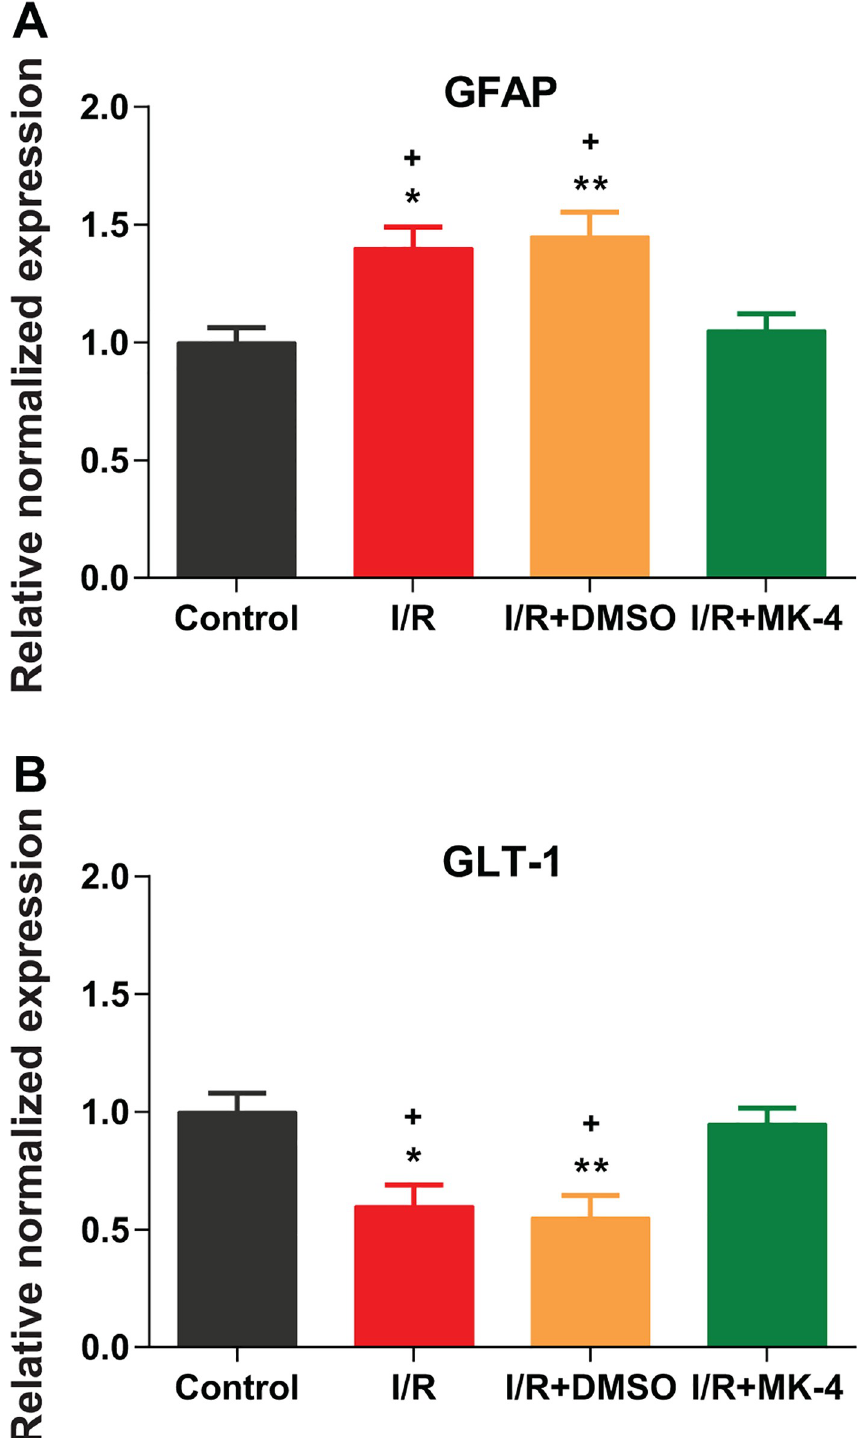
Fig 8. Reduced astrogliosis and EAAT2 (glutamate transporter 1, GLT-1) induction following MK-4 administration in I/R rat model. The mRNA expression level of GFAP and GLT-1 genes was quantified using real- time PCR relative to GAPDH reference gene in rat’s hippocampus. (A) I/R injury induced astrogliosis by elevated GFAP expression level, but MK-4 injection inhibited it. (B) GLT-1 mRNA level was reduced following I/R injury and MK-4 administration backed it to the control level. Data are presented as mean ± SEM. � p < 0.05 and �� p < 0.01 compared to control, + p < 0.05 compared to I/R+MK4 group (n = 6). https://doi.org/10.1371/journal.pone.0229769.g008 PLOS ONE | https://doi.org/10.1371/journal.pone.0229769 March 9,